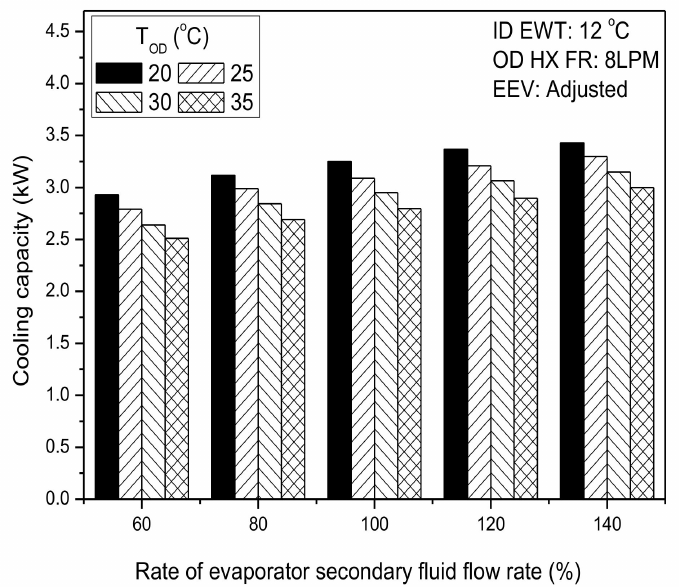
Figure 3. Variation of cooling capacity with evaporator flow rate and condenser inlet water temperature ( T OD ).